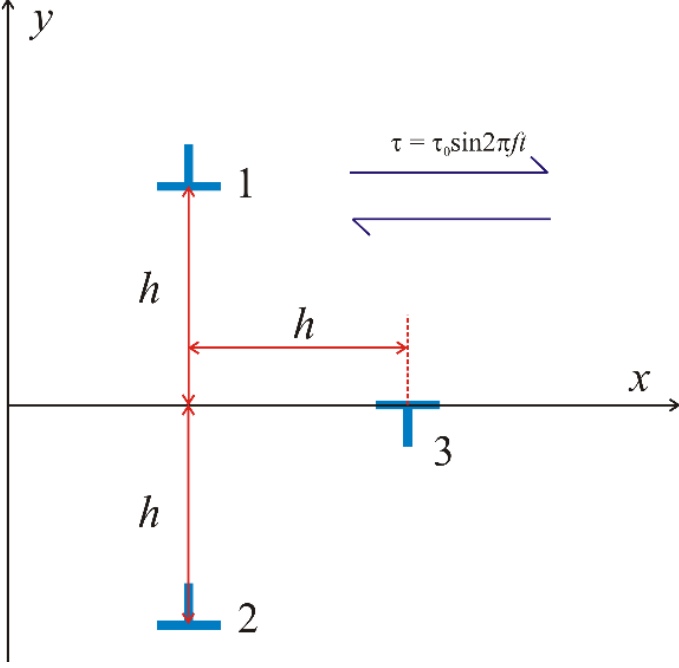
Figure 15. Dislocation tripole in the field of an applied sinusoidal shear stress. 1, 2 and 3 denote the numbers of dislocations.